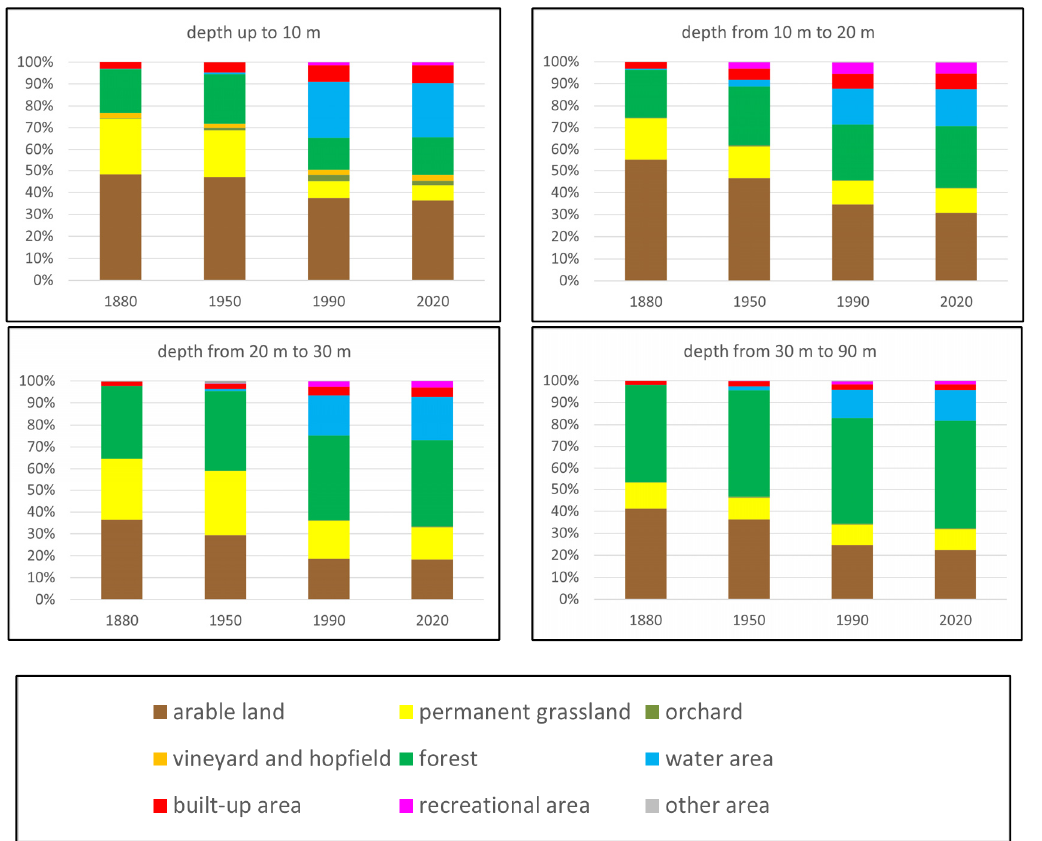
Figure 3. Share (%) of land use categories in water reservoirs and their surroundings in four periods. Water reservoirs were differentiated by their depth.